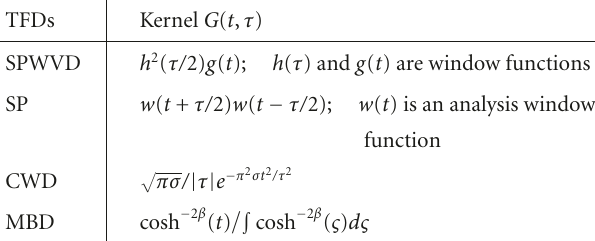
Table 1: TFDs and their corresponding